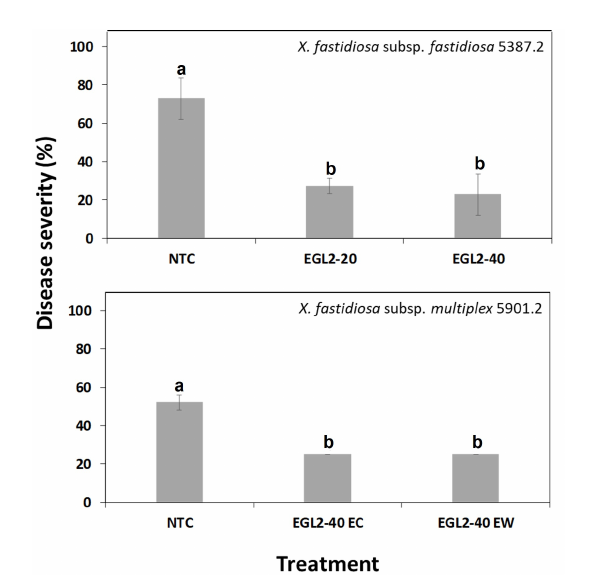
FIGURE 4 Disease severity of ALS in almond plants treated with EGL2 by endotherapy and infected by X. fastidiosa subsp. fastidiosa IVIA 5387.2 or X. fastidiosa subsp. multiplex IVIA 5901.2. Values are the means of 3 replicates of 3 plants, and error bars represent the standard deviation of the mean. The effect of treatments was signi fi cant according to ANOVA (p=0.006 for experiment 1 and p<0.001 for experiment 2). Different letters between treatments indicate signi fi cant differences between disease severities according to Tukey ’ s test (P ≤ 0.05).